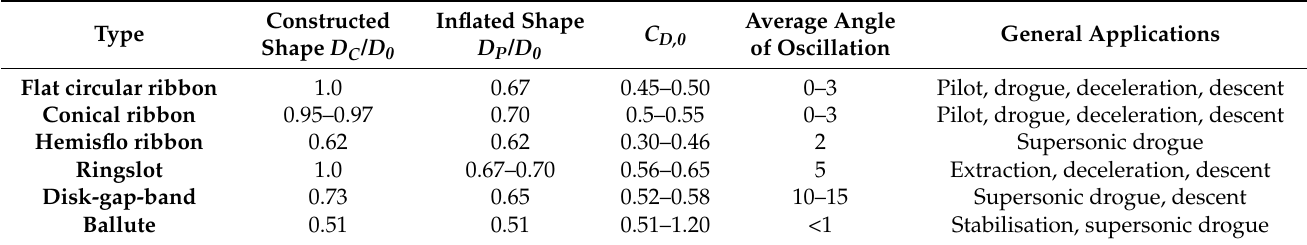
Table 2. Parachute models and characteristics [36].